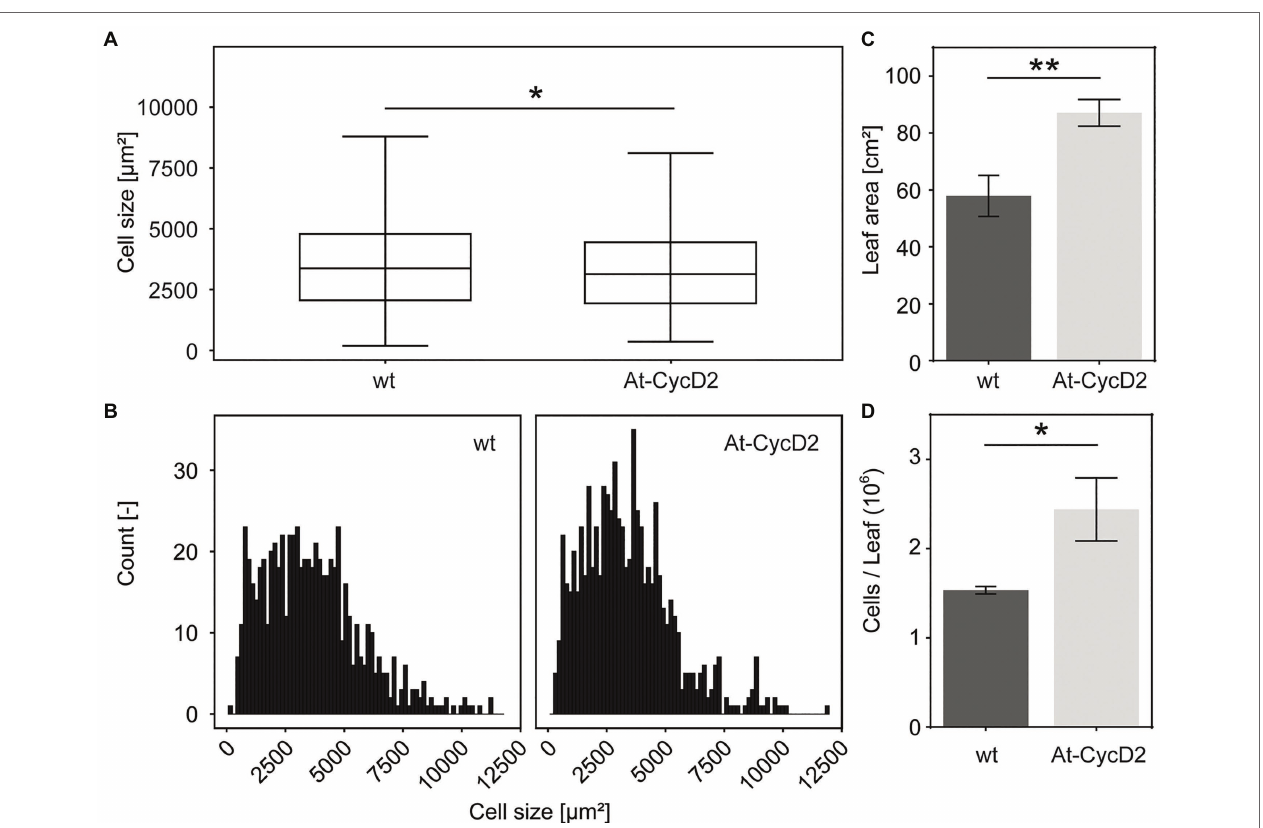
FIGURE 4 | Comparison of leaf size-related characteristics for the At-CycD2-15 line and non-transgenic N. benthamiana plants. The third leaves for measurements were harvested from the wild type and At-CycD2-15 plants grown in soil at 4 weeks after planting. The following parameters were evaluated: epidermal cell area (A) , cell distribution (B) , leaf area (C) and number of cells per leaf (D) . The number of total cells per leaf was calculated from (C) and (A) . The single cell distribution was obtained by pooling cell distributions observed for 3 plants. Values represent the means with standard error. Asterisks indicate significance as determined by the unpaired T -test, with * and ** denoting p < 0.05 and p < 0.01,